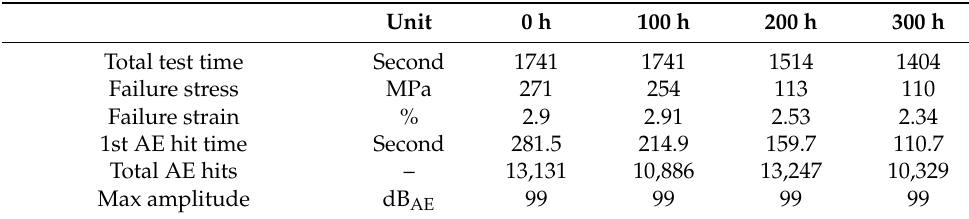
Table 2. Summary of fracture test results.